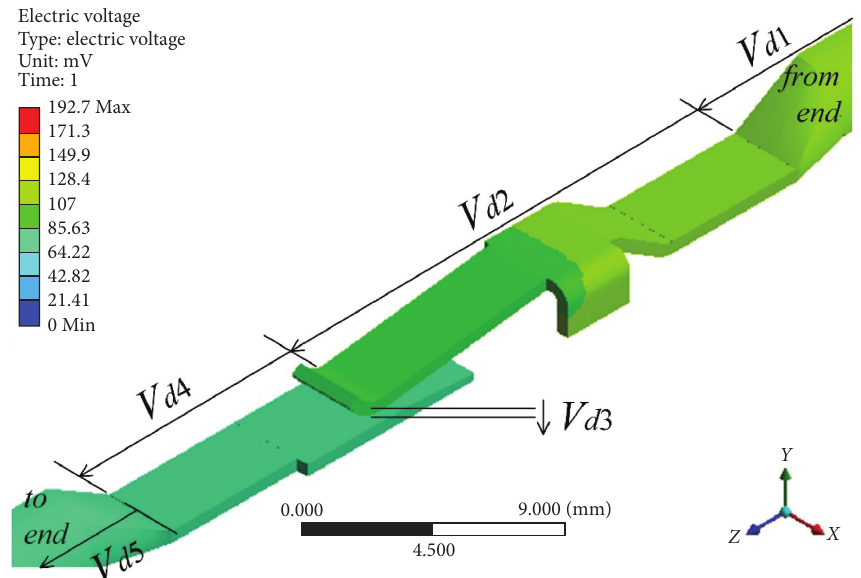
Figure 15: The five parts of the connector. Table 5: The results of t v under all the work conditions. Work condition